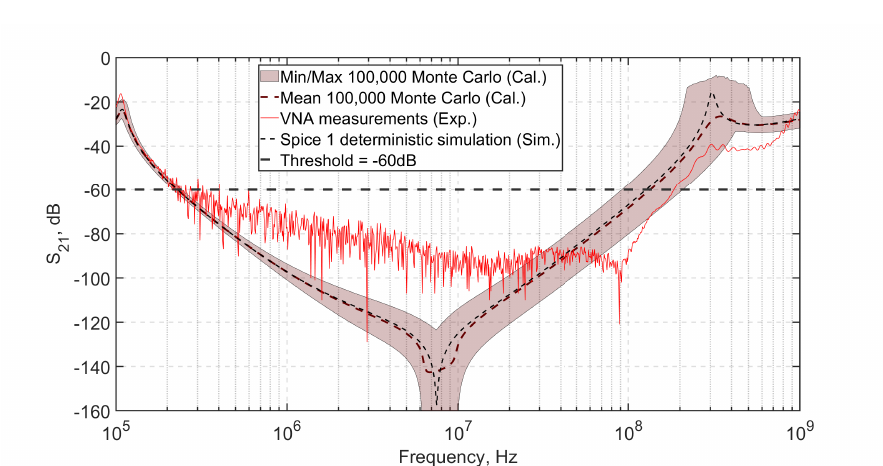
Figure 11. Filtering performances (statistics) from Test case #1/Channel #1 including: VNA measure- ments, simulations (Spice), MC calculations (analytical model).